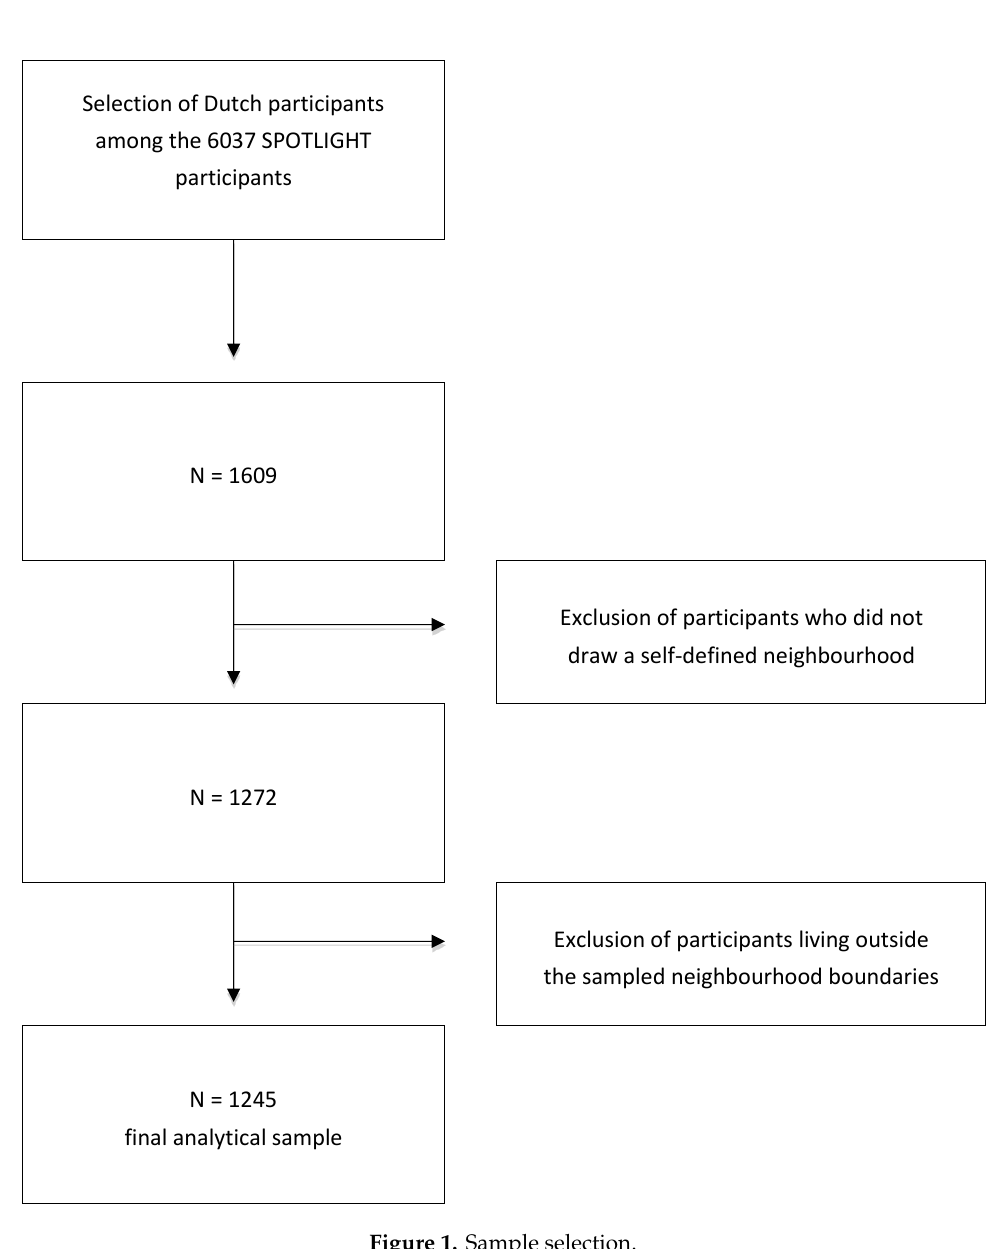
Figure 1. Sample selection.